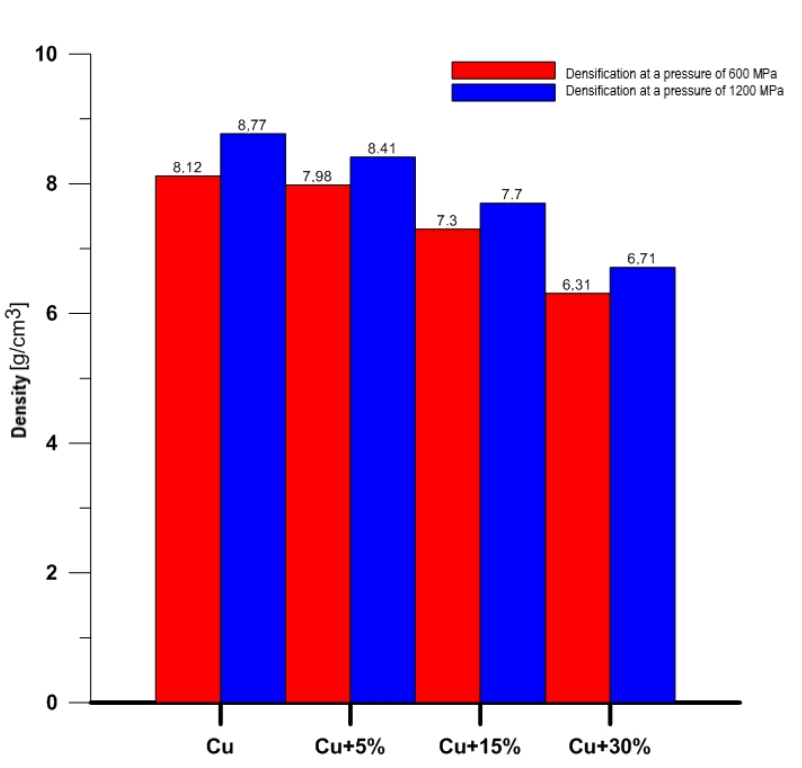
Figure 6. The densities after densification of pure copper and composites with tuff.